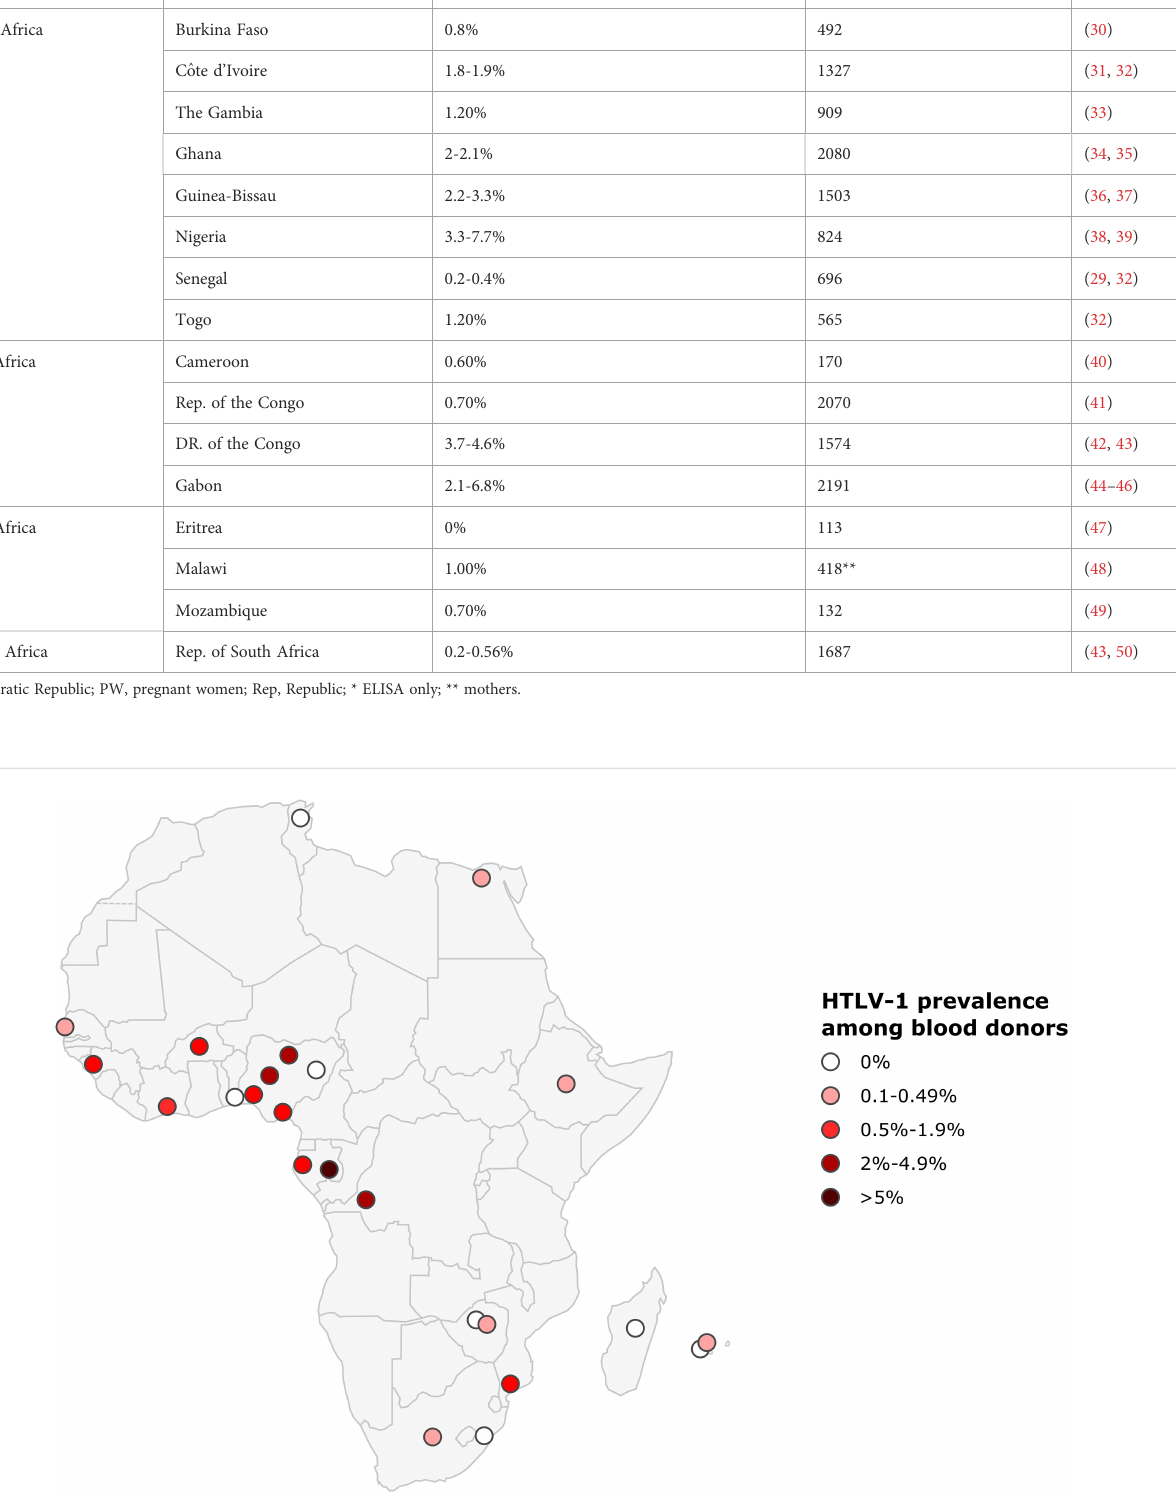
FIGURE 5 Map of Africa showing location and results of HTLV-1 prevalence studies among blood donors. The range of HTLV-1 prevalence is indicated by color of red gradient. In case of great geographical or inter-studies variations in prevalence within a country, each result was represented separately at the site of the study location (when available).